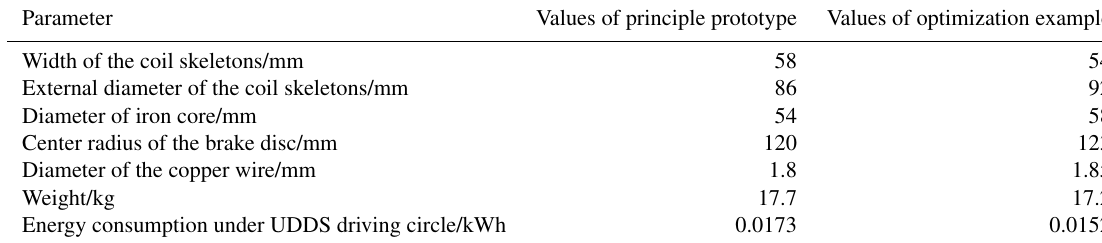
Table 2. Comparison between the original parameters and the optimized parameters.